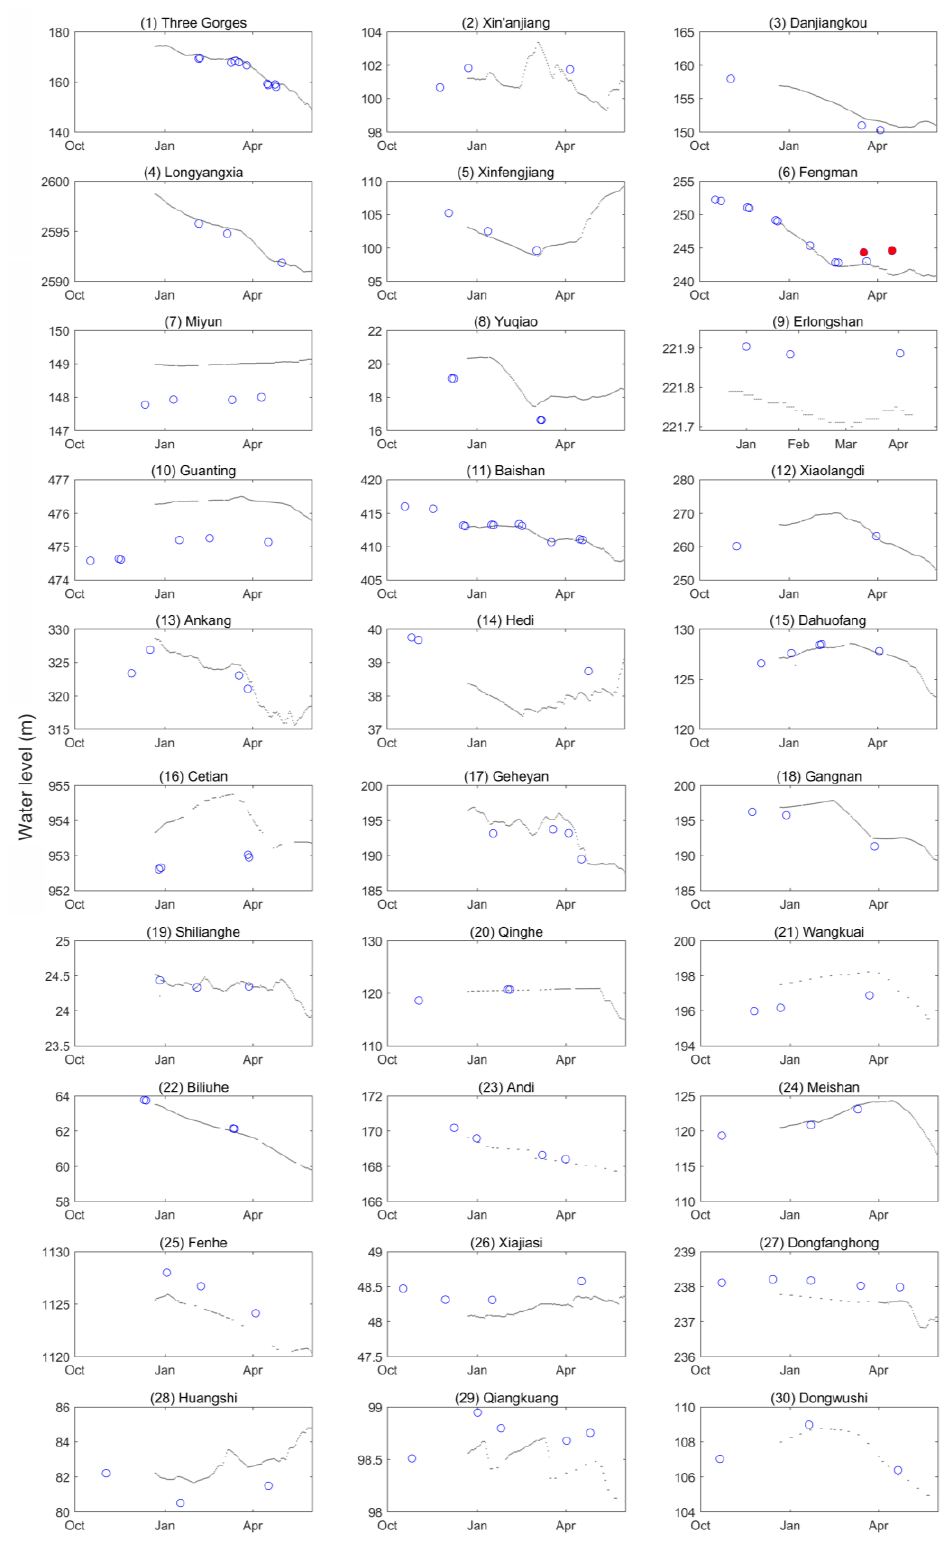
Figure 3. Comparison of water levels from the ICESat-2 data and gauge records over 30 reservoirs. The time span is from October 2018 to May 2019. Gauge water levels and observed water levels are shown in grey dots and blue circles, and altimetric water levels of large measurement uncertainty (the standard deviation of along-track heights is greater than 0.10 m) are marked with red dots.